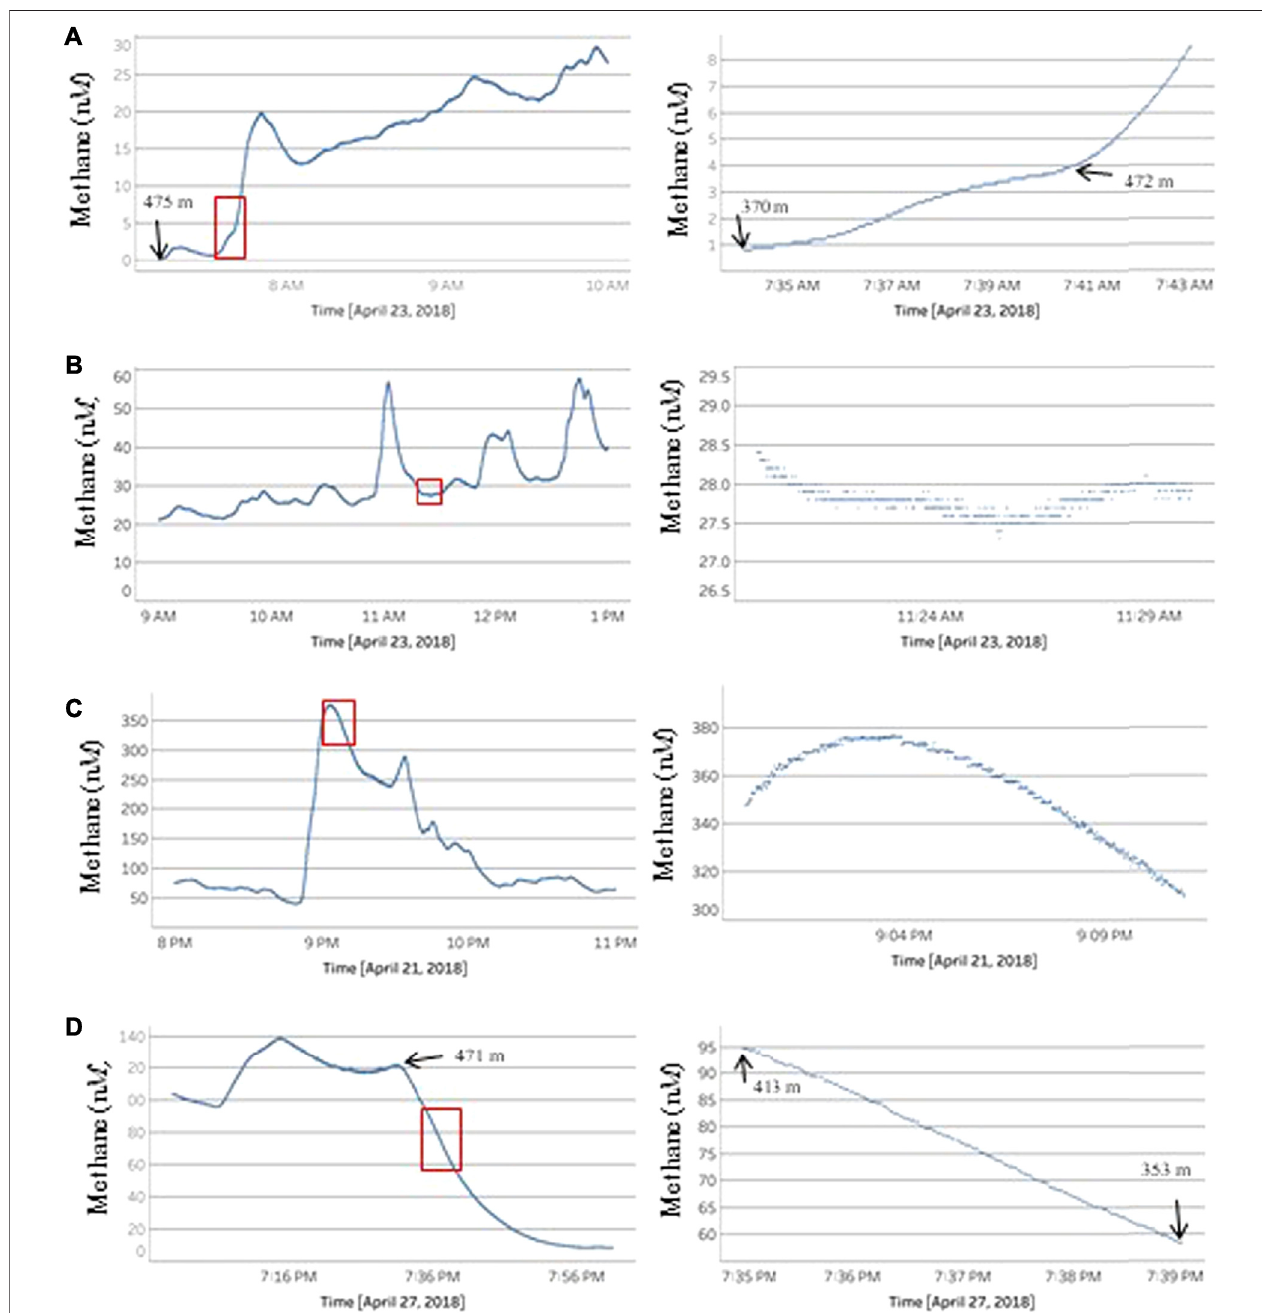
FIGURE2| Plotsofmethane-datatimeseriesforglider187resolvedathourandminutescales(samplingfrequencyis1 Hz).Foreachlongerperiod timeseries,an insetboxshowstheintervalpresented attheminute timescaleontherightside.Keywaterdepths arenotedontheplotsfordescendingpart (A) andascendingpart (D) paths. Water depth for traverse paths are near constant at ∼ 475 m part (B) and ∼ 550 m part (C) .